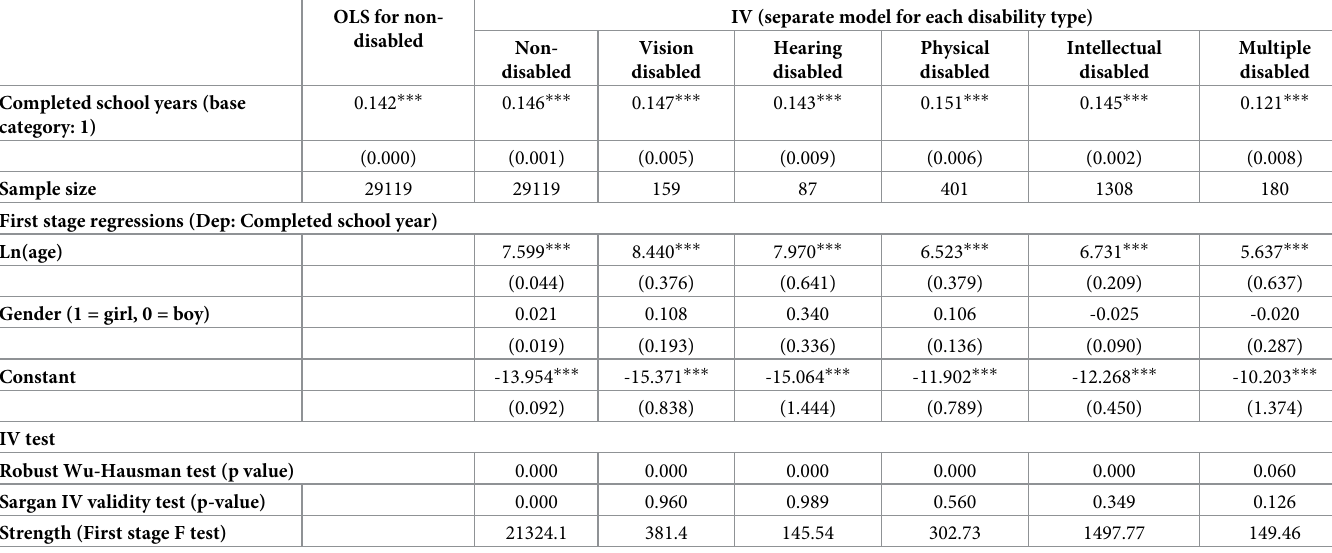
Table 4. Regressions on the mean numeracy score by disability